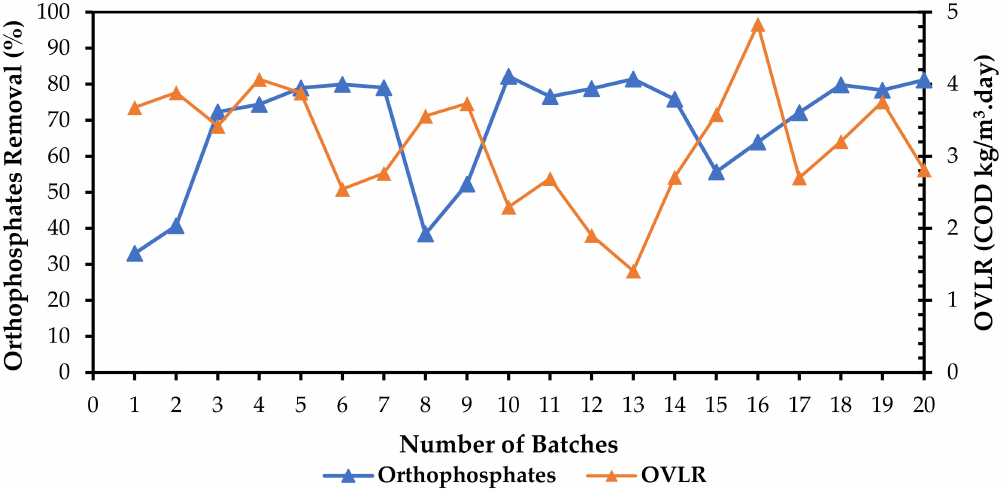
Figure 5. Orthophosphate removal with variation in